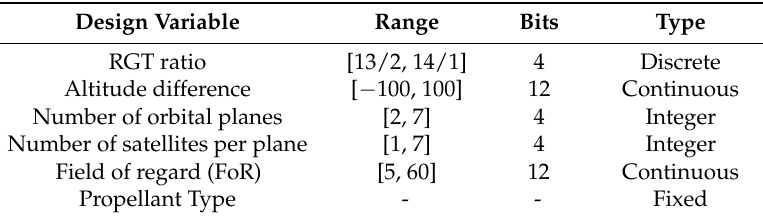
Table 15. Range and initial value of design variables in GA.